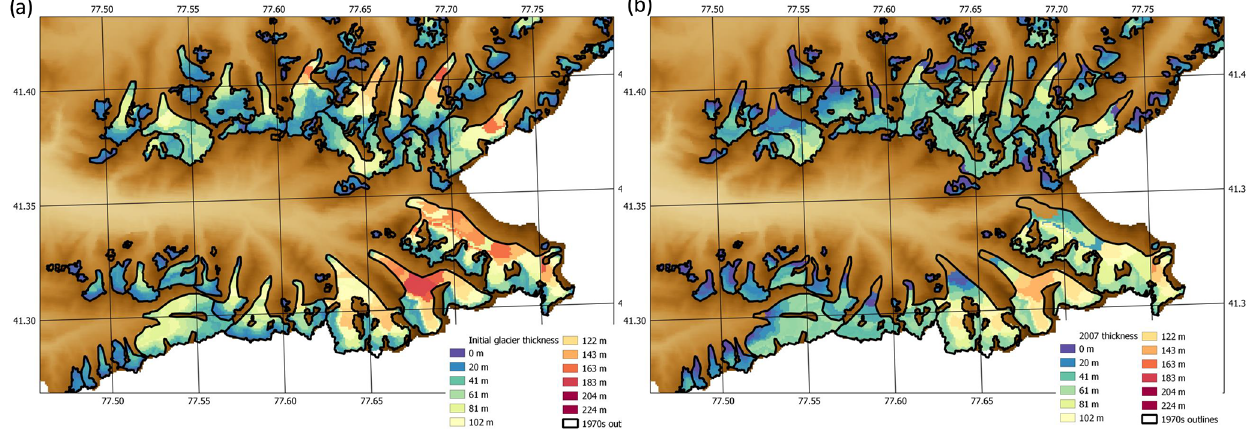
Figure 7. Panel (a) shows initial glacier thicknesses on HRUs calculated using GlabTop2 in the upper part of the Naryn catchment. 1970s glacier outlines are shown in black. Panel (b) shows the annual mean thickness for the year 2007 for the median ensemble mem- ber in the top 0.5% calibration simulations.